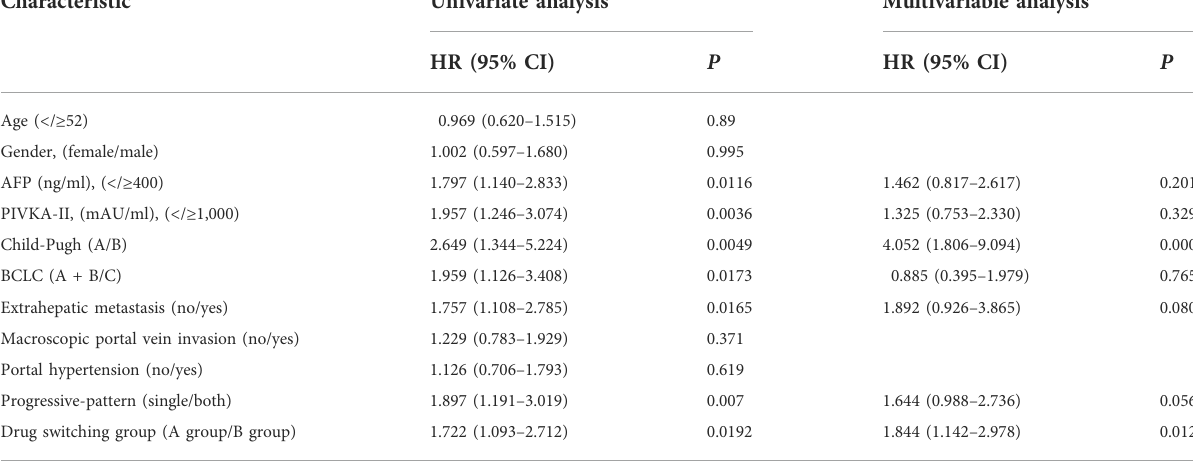
TABLE 6 Univariable and multivariable Cox regression analyses for second progression-free survival.